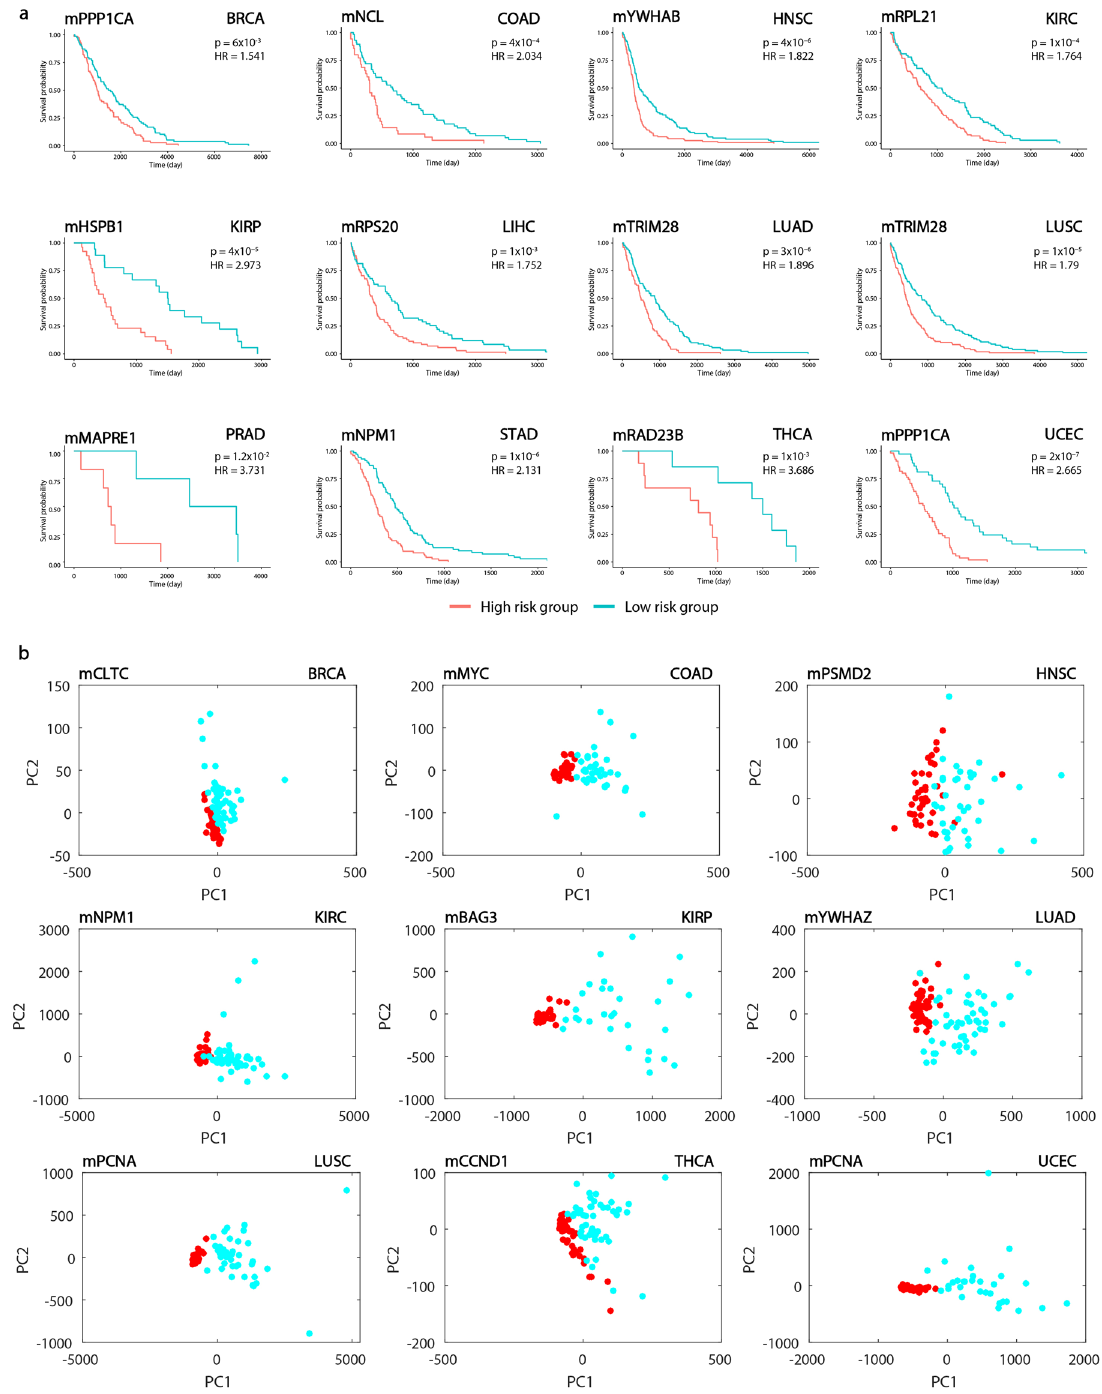
Figure 6. Prognostic and principal component analyses for different cancer types. ( a ) Kaplan-Meier Plots estimating patients’ survival for 12 cancer types indicating p-value and hazard ratio for each curve. ( b ) PCA plots showing the individual differences in the gene expression profiles among the cancers including at least 30 individuals in each